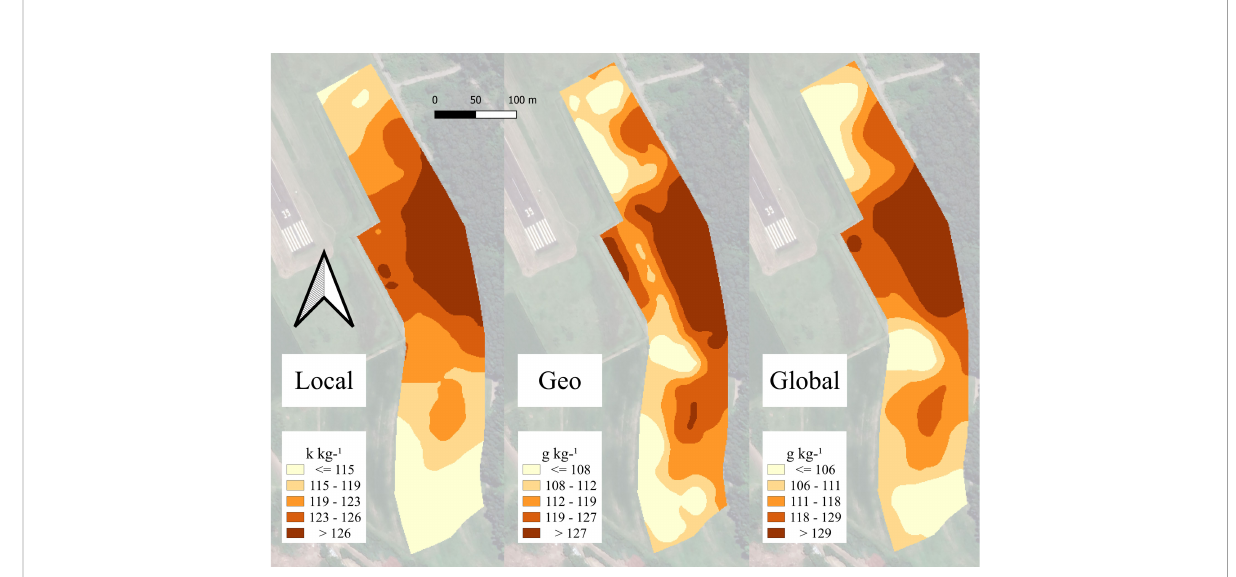
FIGURE 6 Maps of the fi ve quantiles obtained by ordinary kriging for clay prediction using three different strategies of calibration only in- fi eld samples (local), adding samples from the same geological region (geological), and adding samples from different geological regions